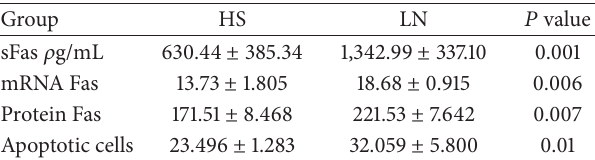
Table 2: Biomarkers in HS and lupus